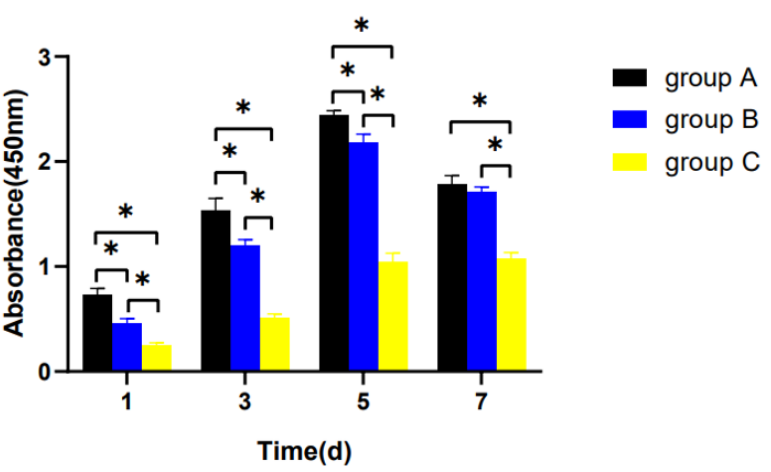
Figure 4. Cell proliferation in the three groups. hDPSCs were cultured with a complete culture medium for 1 week. The proliferation level was assessed with the CCK-8 assay on days 1, 3, 5, and 7. * p < 0.05.